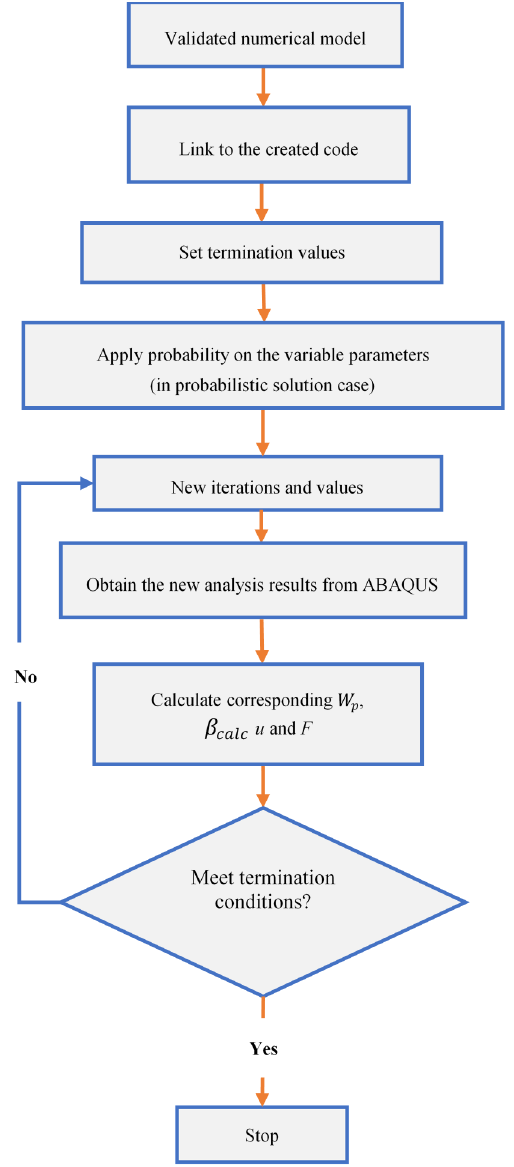
Figure 1. Optimization problem details.